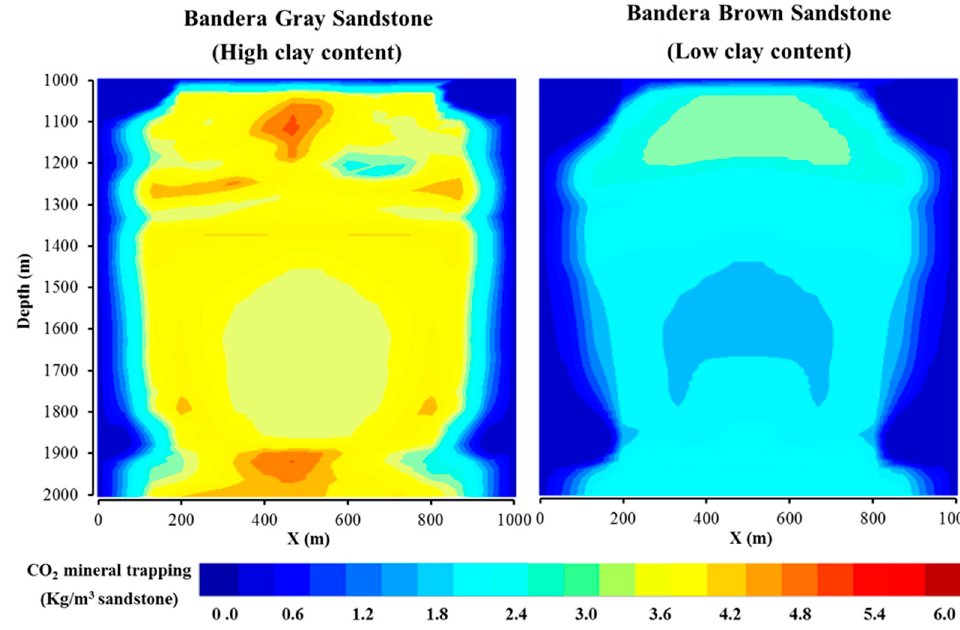
Figure 5. Sequestered in Minerals (SMCO 2 ) for the high and low clay-content sandstones after 400 years post-injection time.